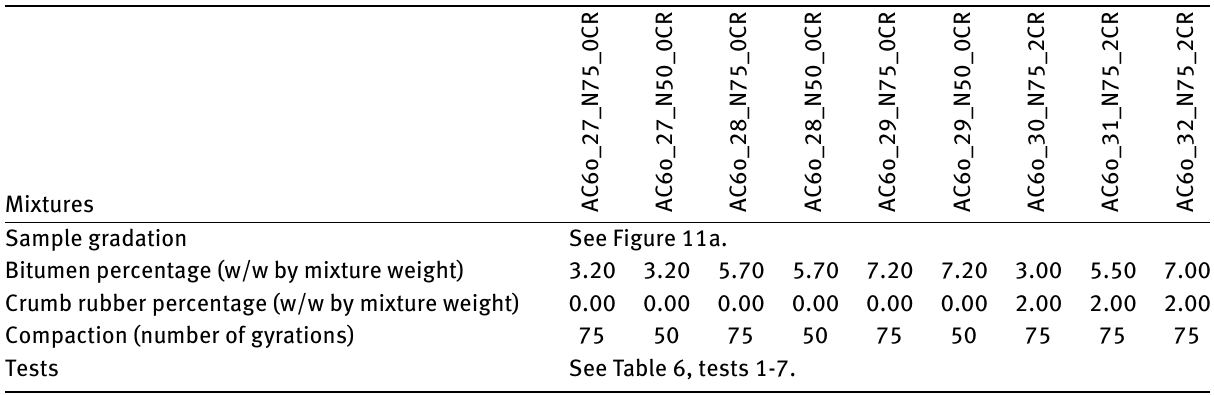
Table 5: Design of